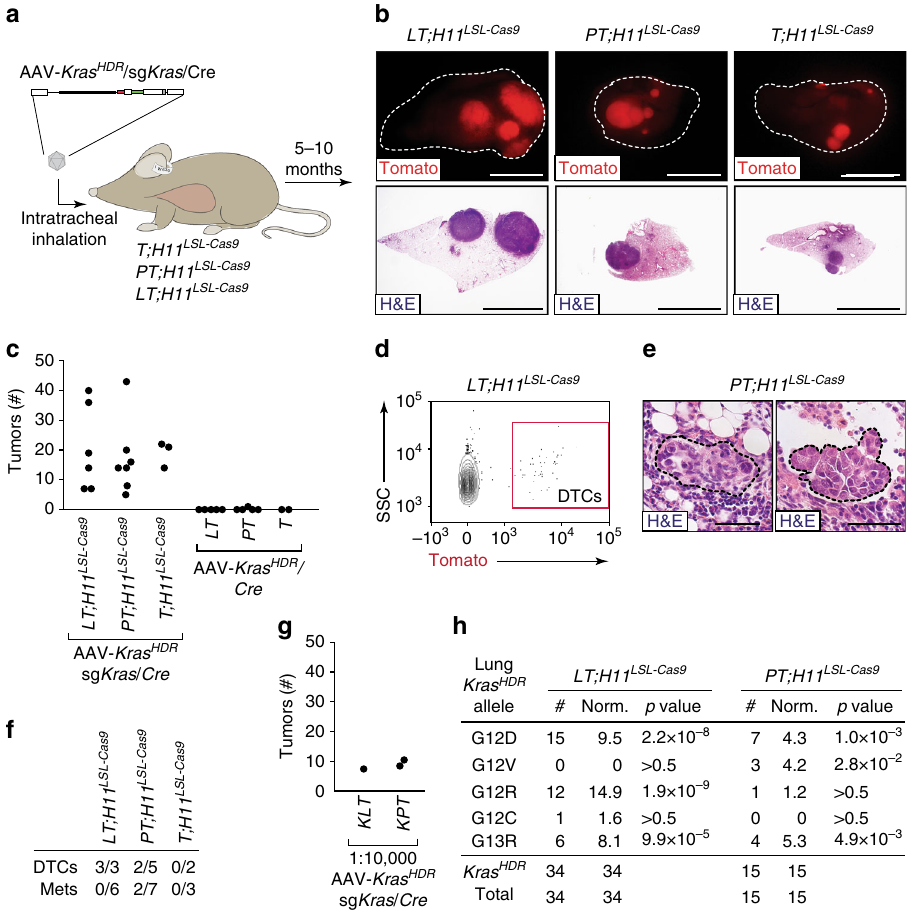
Fig. 3 AAV/Cas9-mediated somatic HDR initiates oncogenic Kras-driven lung tumors. a Schematic of the experiment to introduce point mutations and a DNA barcode into the endogenous Kras locus of lung epithelial cells in Rosa26 LSL-Tomato ;H11 LSL-Cas9 ( T;H11 LSL-Cas9 ), p53 fl ox/ fl ox ;T;H11 LSL-Cas9 ( PT;H11 LSL-Cas9 ), and Lkb1 fl ox/ fl ox ;T;H11 LSL-Cas9 ( LT;H11 LSL-Cas9 ) mice by intratracheal administration of AAV- Kras HDR /sg Kras / Cre (8.4 × 10 10 vector genomes per mouse). b Representative fl uorescence and histology images of Tomato positive lung tumors in LT;H11 LSL-Cas9 , PT;H11 LSL-Cas9 , and T;H11 LSL-Cas9 mice transduced with AAV- Kras HDR /sg Kras / Cre . Scale bars = 5 mm. c Quanti fi cation of lung tumors in the indicated genotypes of mice transduced with the indicated AAV vectors (with and without sg Kras ). Each dot represents one mouse. d Representative FACS plot showing Tomato positive DTCs in the pleural cavity of an LT; H11 LSL-Cas9 mouse with AAV- Kras HDR /sg Kras / Cre -initiated lung tumors. Plot shows forward scatter/side scatter (SSC)-gated viable cancer cells (DAPI/ CD45/CD31/F4-80/Ter119 negative ). e Histology of lymphatic metastases from AAV- Kras HDR /sg Kras / Cre -initiated lung tumors in PT;H11 LSL-Cas9 mice. Scale bar = 50 µ m. f Number of AAV- Kras HDR /sg Kras / Cre -transduced mice of each genotype that had disseminated tumors cells in their pleural cavity (DTCs > 10) or metastases out of the total number of mice analyzed. g Kras LSL-G12D /+ ;LT ( KLT ) and Kras LSL-G12D /+ ;PT ( KPT ) mice transduced with a 1:10,000 dilution of AAV- Kras HDR /sg Kras / Cre developed approximately half as many tumors as the PT;H11 LSL-Cas9 and LT;H11 LSL-Cas9 mice transduced with undiluted virus. If all Kras HDR alleles in the AAV- Kras HDR /sg Kras / Cre library are oncogenic, this suggests that AAV/Cas9-mediated HDR occurs in ~0.02% of transduced cells. Alternatively, if only 20% of the mutant alleles in the AAV- Kras HDR /sg Kras / Cre library are oncogenic, this suggests that HDR occurs in ~0.1% of transduced cells. h Diverse HDR-generated oncogenic Kras alleles in individual lung tumors dissected from LT;H11 LSL-Cas9 and PT;H11 LSL-Cas9 mice transduced with AAV- Kras HDR /sg Kras / Cre . Number of tumors with each allele is indicated. Alleles that were not identi fi ed in any lung tumors are not shown. For the Kras HDR alleles identi fi ed, Bonferroni corrected p values for likelihood of enrichment relative to WT are shown (Fisher ’ s exact test generalized for structural zeros; see Methods